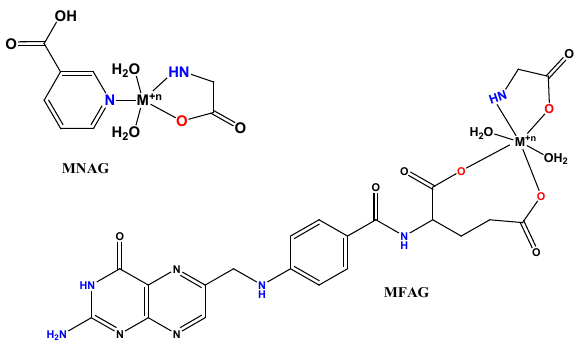
Scheme 2 : Proposed molecular structures of mixed ligand complex involving nicotinic acid (NA), folic acid (FA) and glycine